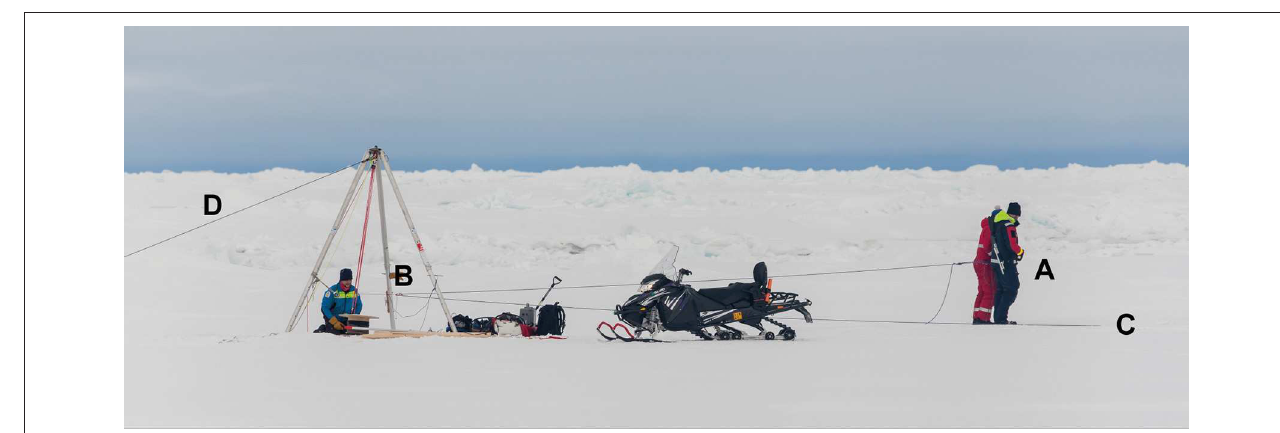
FIGURE 6 | Overview of the recovery procedure. Two persons (A) pull up the load with the 2:1 pulley system. The loop pulley rope is fixed in the ground (C) and diverted in the multiplier block (B) . Note the guy rope (D) that is necessary to keep the tripod from tipping over. Picture was taken during the training session, where a bigger tripod was used. No Skidoo was available during the actual